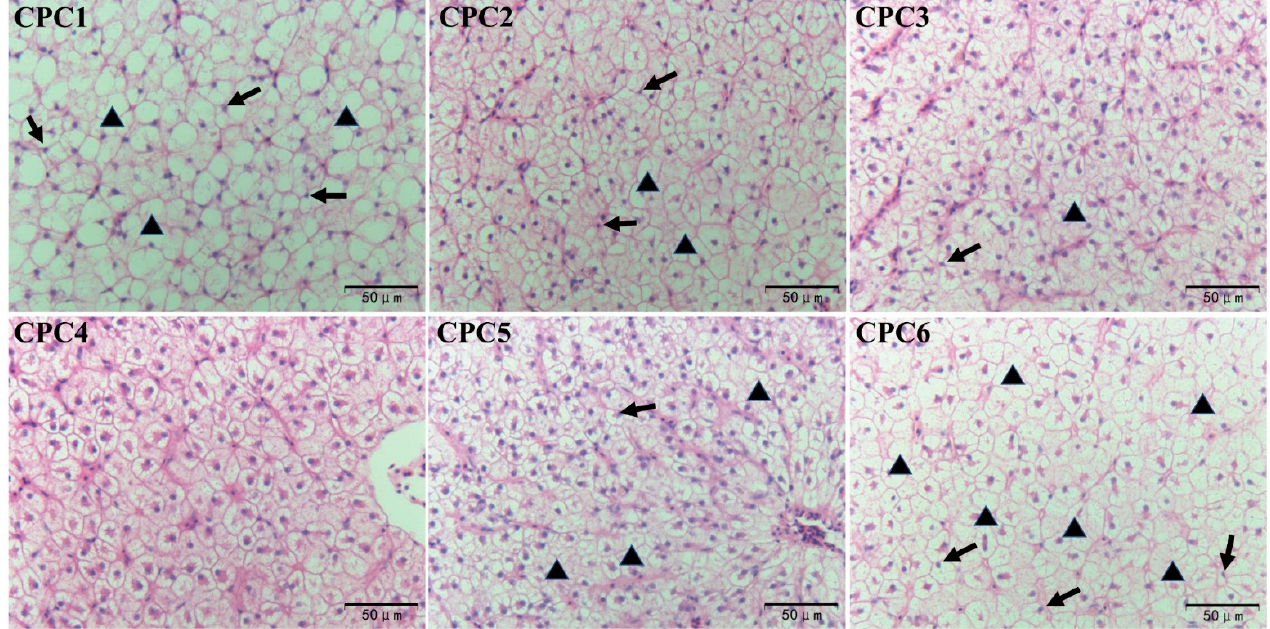
Figure 3. Hepatopancreatic histology of grass carp (hematoxylin and eosin, ×400). Arrows indicate nuclei shifted to the periphery of the hepatocytes; triangles indicate vacuolation. Table 6. Effects of the dietary protein levels on the muscle texture of grass carp 1